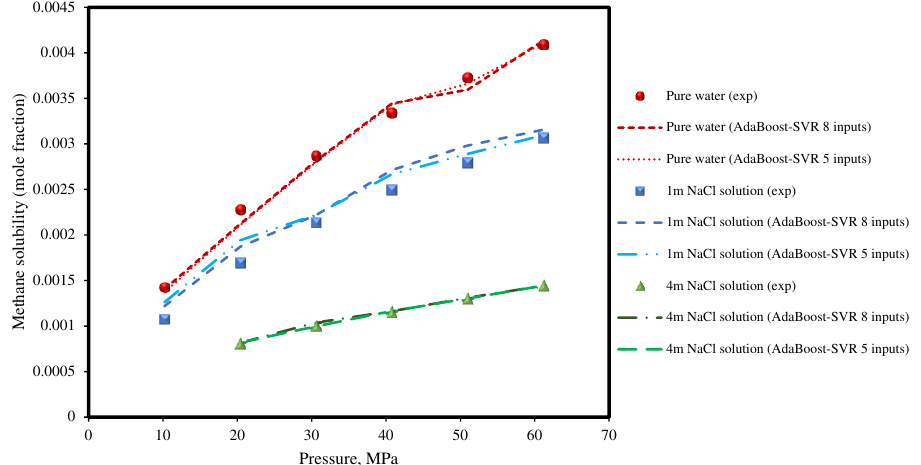
Figure 10. Experimental methane solubilities in water and aqueous NaCl solutions at a temperature of 324.65 K along with AdaBoost-SVR models